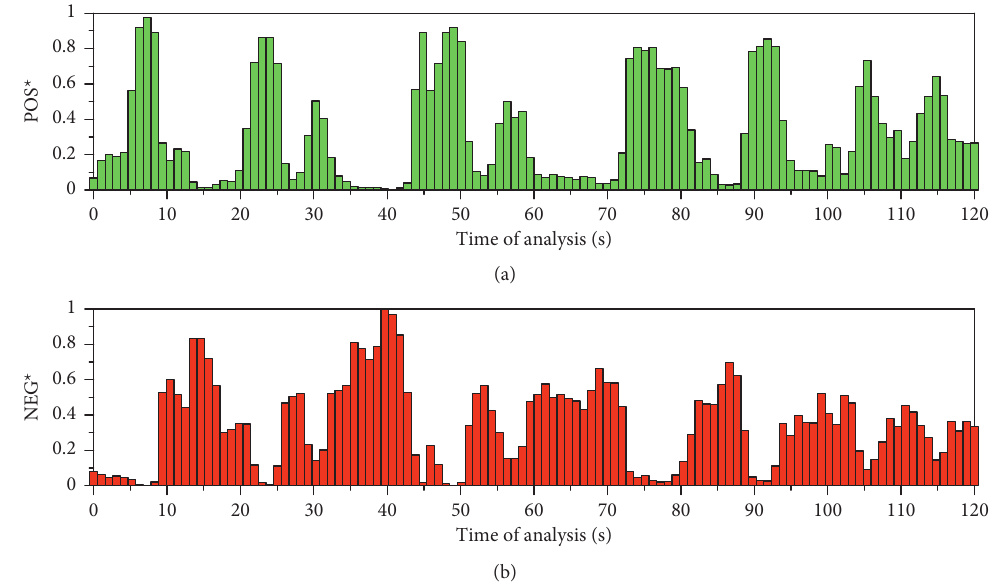
Figure 7: Example of calculated (a) POS ∗ and (b) NEG ∗ measurements of AU signals, as obtained for one of the participants under the VR input source.